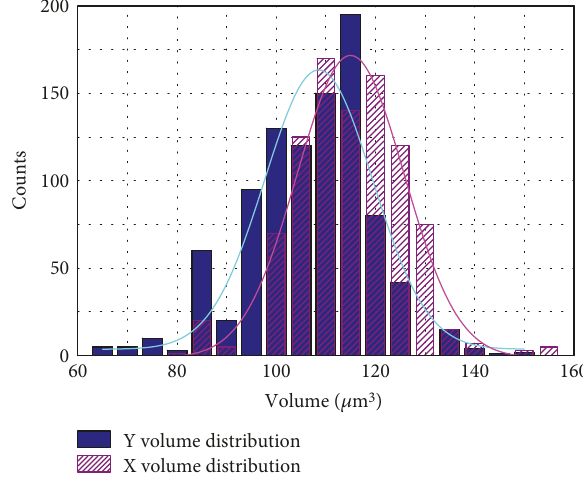
Figure 6: Volume distributions for X- (purple) and Y- (blue) bearing spermatozoa heads. The Gaussian fi t for the two volume distributions is